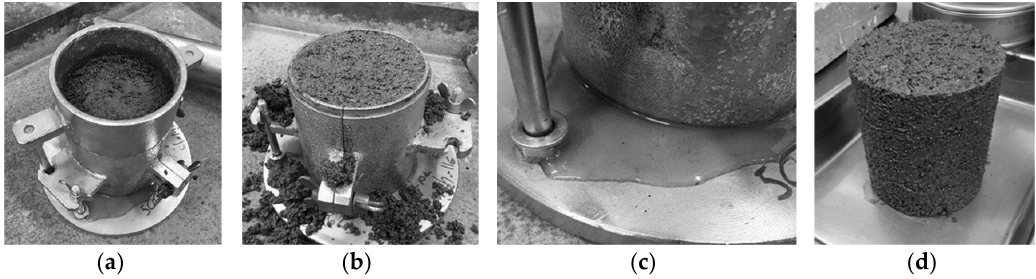
Figure 4. Laboratory reference density and water content by Proctor compaction method: ( a ) Specimen with mold during compactions; ( b ) Compacted quarry fine specimen in mold; ( c ) Self-draining water during the compaction; ( d ) Compacted quarry fine specimen for water content determination.